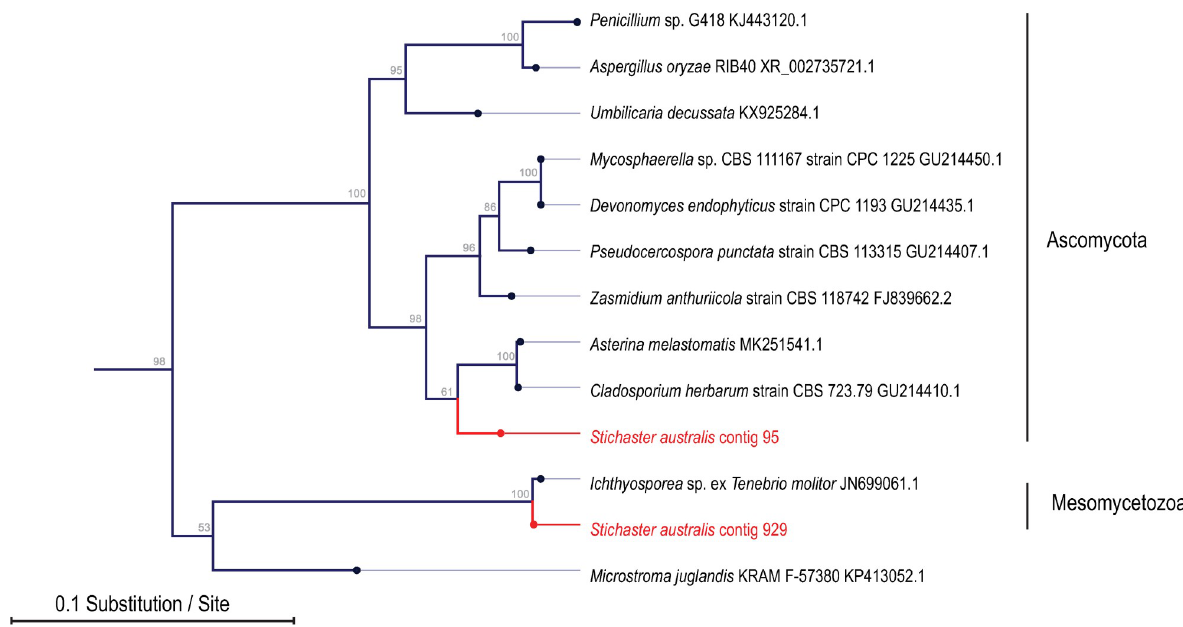
Fig 4. Phylogenetic representation of asteroid-associated 28S rRNA sequences in purified virus metagenomes. The tree was constructed by neighbor joining and based on an 849 nucleotide alignment of eukaryotic 28S rRNA. Shown are close matches by BLAST against the non-redundant database.